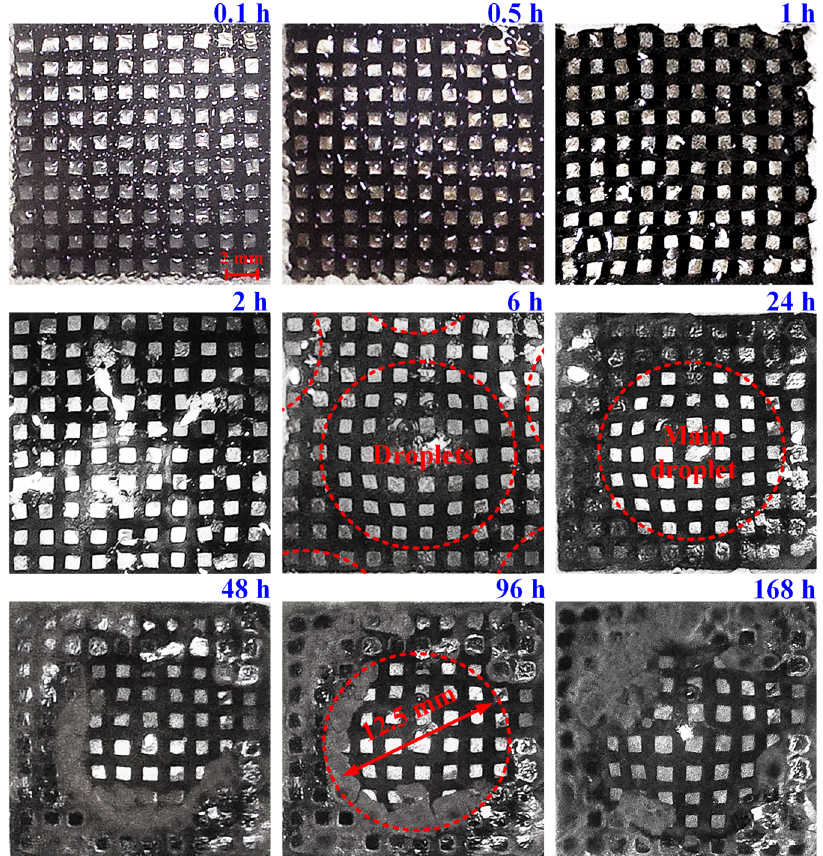
Fig. 1 The formation process of the droplets on the WBE surface. The distribution of the water droplets on the WBE surface photographed by the endoscope at different test